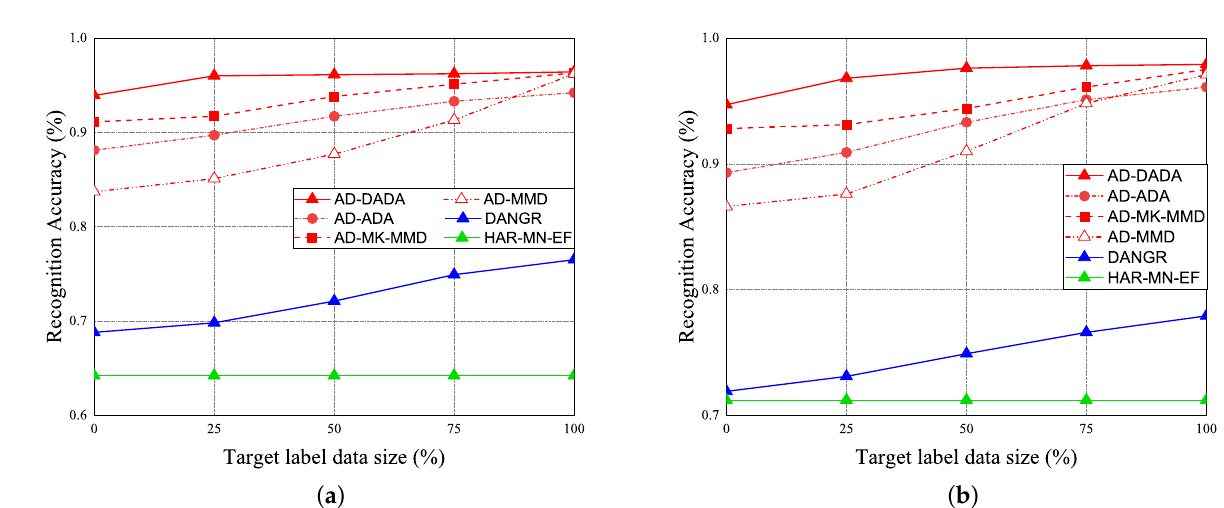
Figure 22. RA vs. various ratios of labeled data for ( a ) target (A) and ( b ) target (B) under target data ratio = (1:1:0.5:1:0.5).